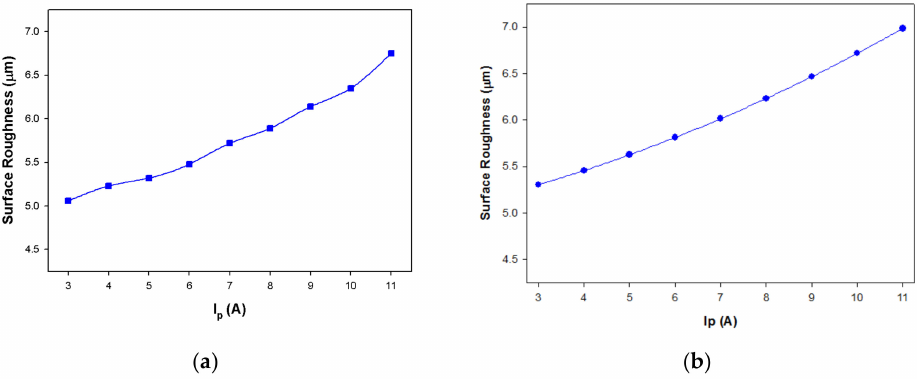
Figure 7. Main effect plots for SR with I p using ( a ) DOE model; ( b ) machine learning model.